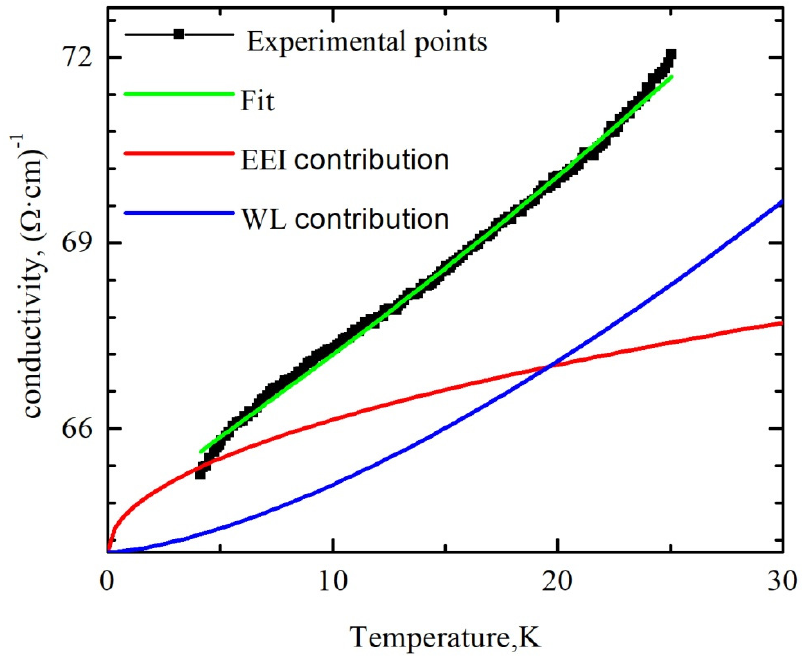
Figure 10. Temperature dependence of the conductivity of polycrystalline SnO 2 − δ film (sample B). The solid lines are the fits by Formula (11).